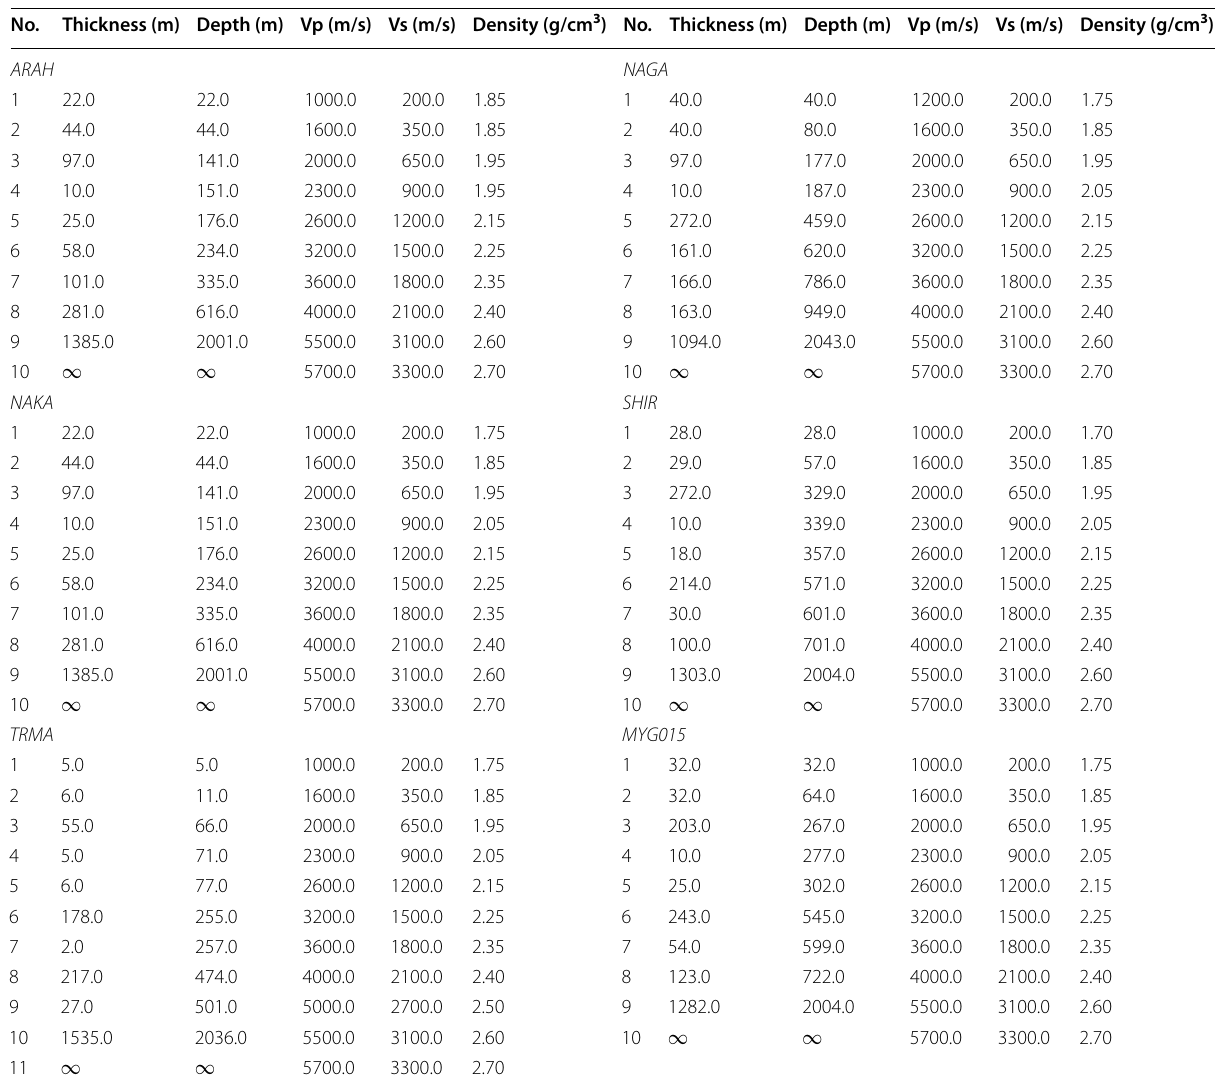
Table 5 Initial underground structure based on the J-SHIS data No. Thickness (m) Depth (m) Vp (m/s) Vs (m/s) Density (g/cm 3 ) No. Thickness (m) Depth (m) Vp (m/s) Vs (m/s) Density (g/cm 3 ) ARAH